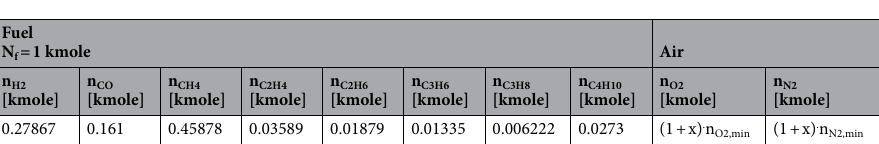
Table 4. The mole composition in the flow section “0”. where n O2,min = 0.5 n H2 + 0.5 n CO + 2 n CH4 + 3 n C2H4 + 3.5 n